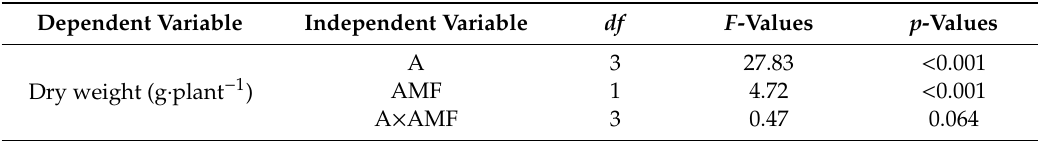
Figure 1. Mycorrhizal colonization rate ( A ) and growth ( B ) of P. tenuiflora seedlings under alkali stress. The bars represent the means ± S.E. The di ff erences were considered significant when p < 0.05 and indicated by di ff erent letters. Table 1. ANOVA e ff ects of alkalinity concentration (A), arbuscular mycorrhizal fungi (AMF) and their interactions on the growth of Puccinellia tenuiflora seedlings.